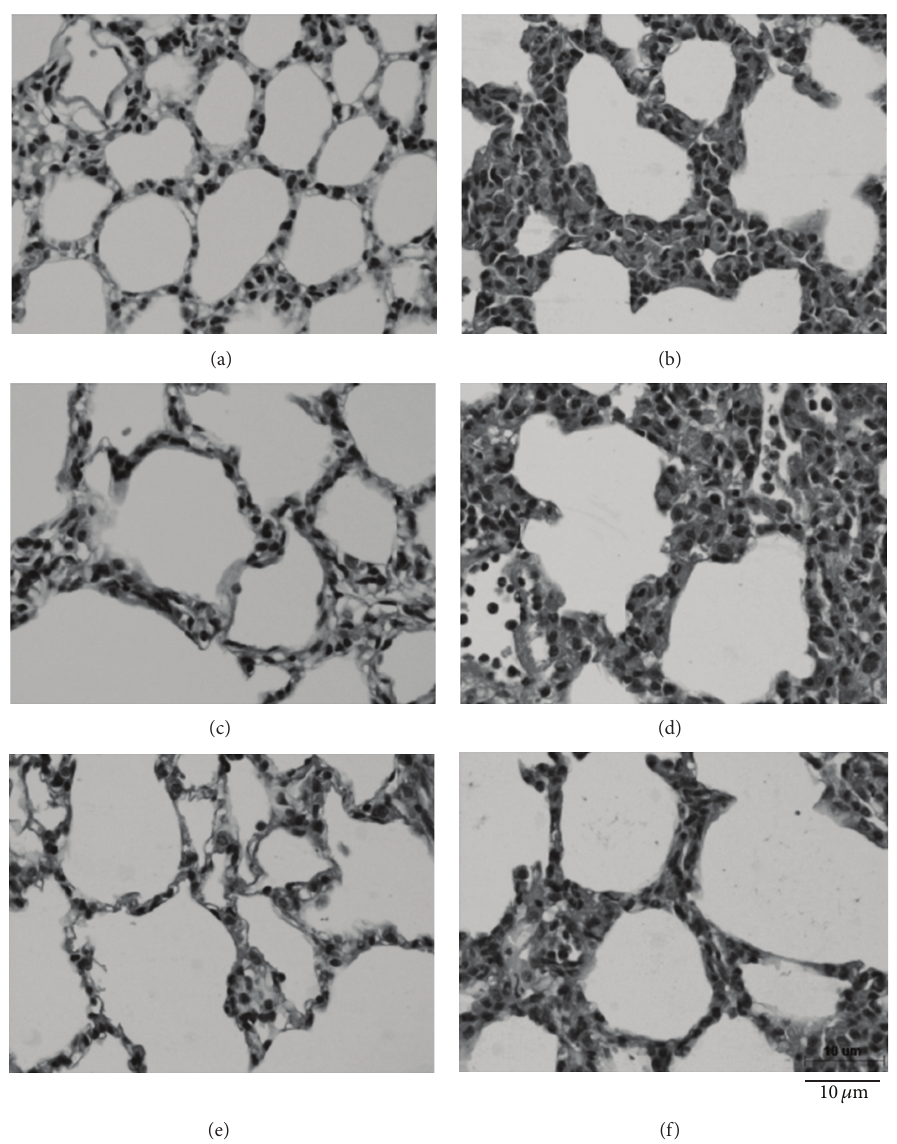
Figure 6: Histological examination of right upper lobe taken after 240min of saline or LPS administration. (a) NS: nondiabetic rats injected with saline; (b) NL: nondiabetic rats injected with LPS; (c) SS: STZ-induced diabetic rats injected with saline; (d) SL: STZ-induced diabetic rats injected with LPS; (e) SES: STZ-induced diabetic rats with exercise injected with saline; (f) SEL: STZ-induced diabetic rats with exercise injected with LPS. The interstitial spaces of alveoli became wider after LPS administration, due to polymorphonuclear cell infiltration and edematous changes of alveolar walls (b), (d). Scale bar: 10 𝜇 m. Table 1: Effects of LPS administration (15mg/kg, i.v.) on arterial blood gas in rats with or without exercise. pH NS